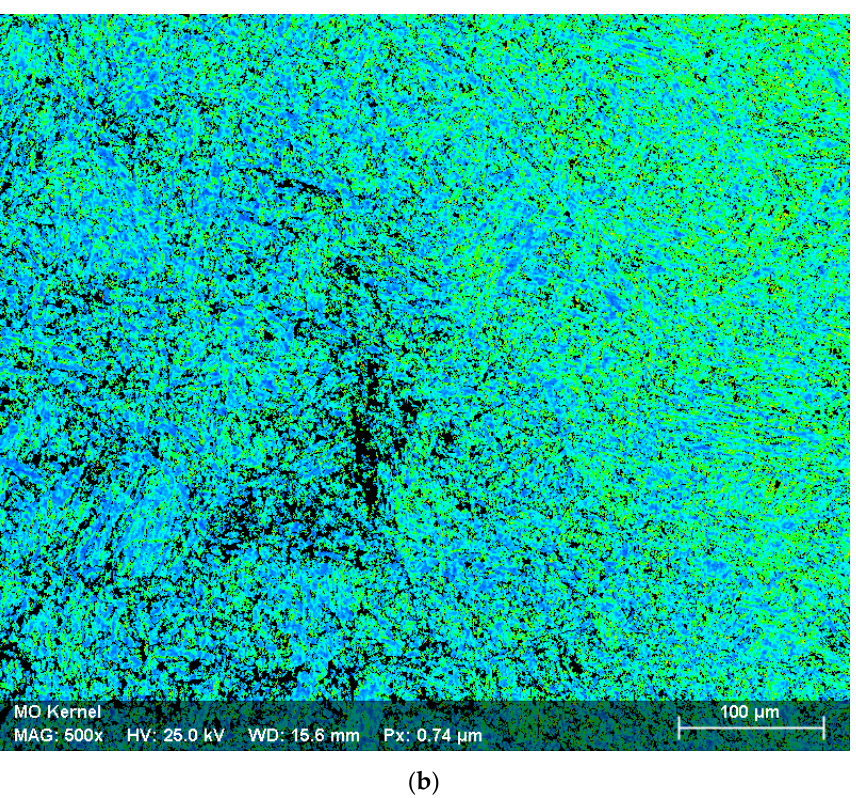
Figure 9. Maps of kernel average misorientation (KAM): ( a ) first day of monitoring KAM map and ( b ) fourth day of monitoring KAM map. EBSD with magnitude of 500×.